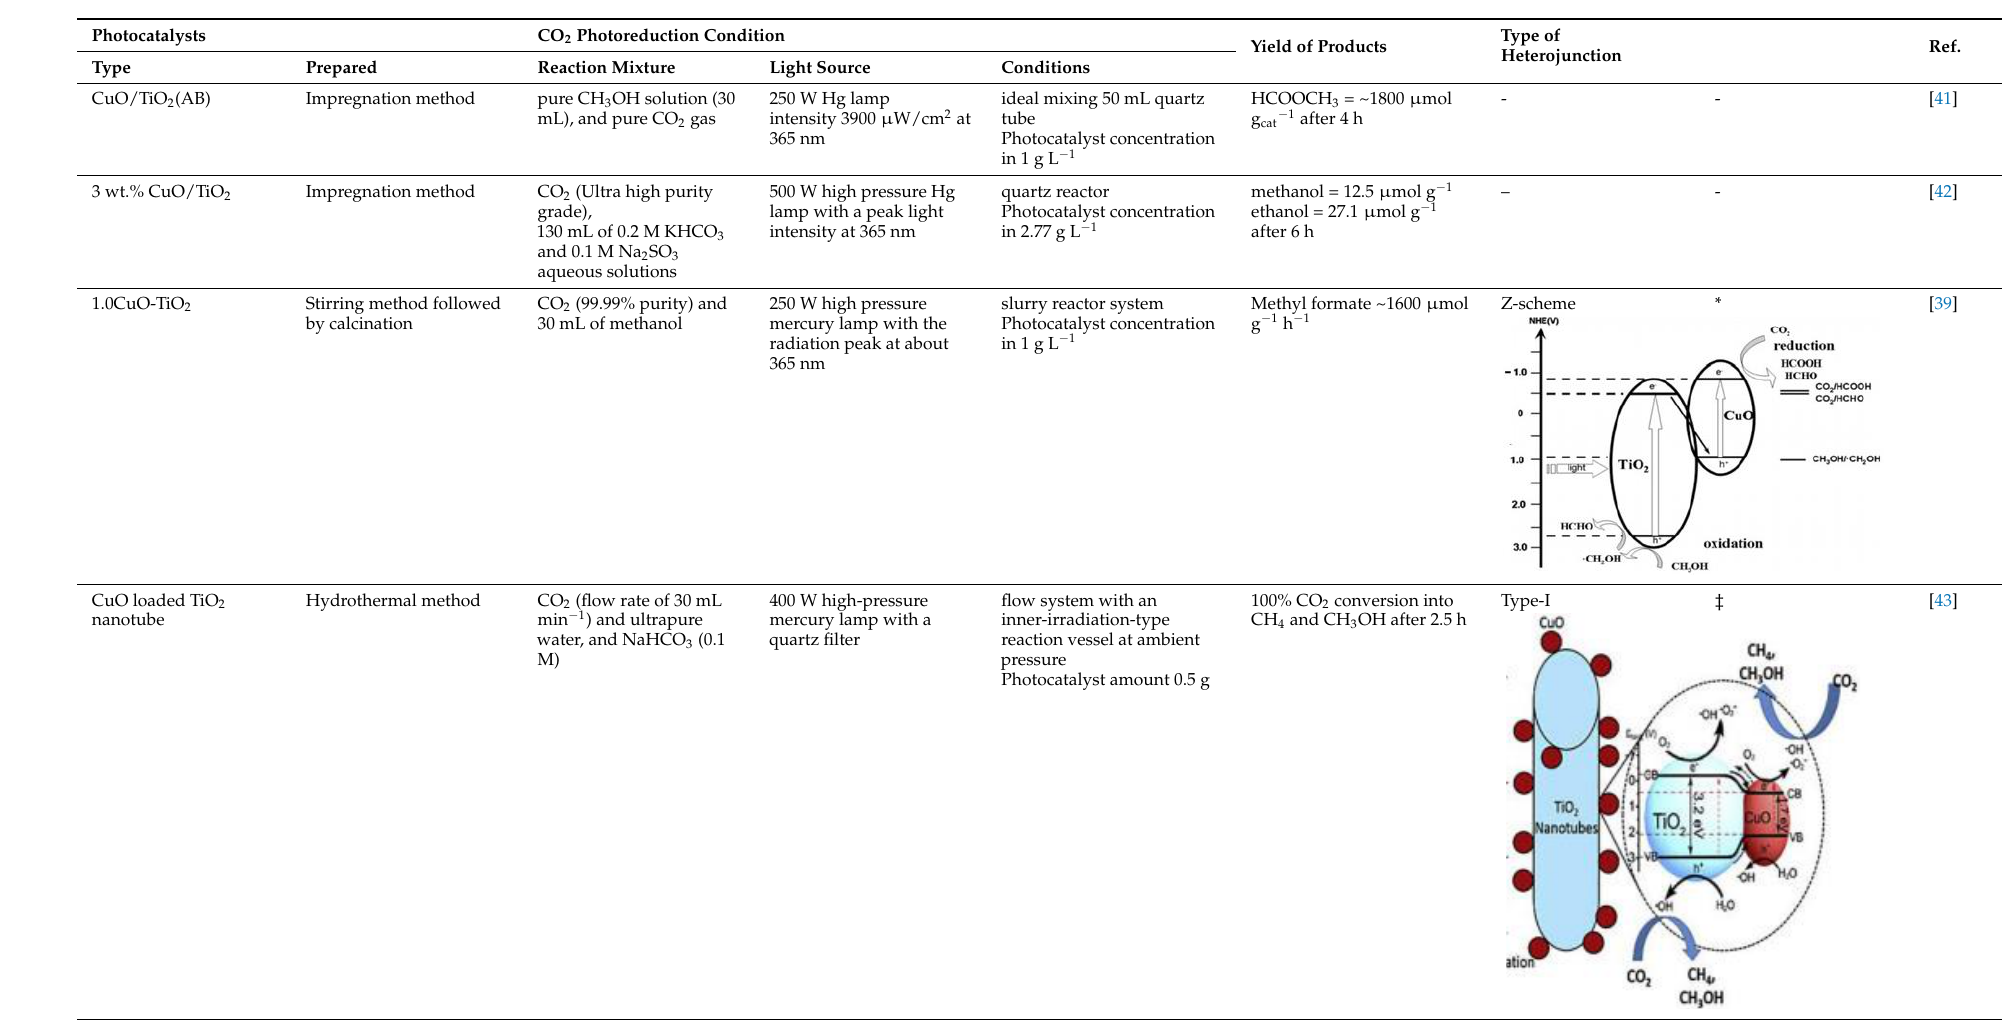
Table 4. CO 2 photoreduction using CuO/TiO 2 heterojunction